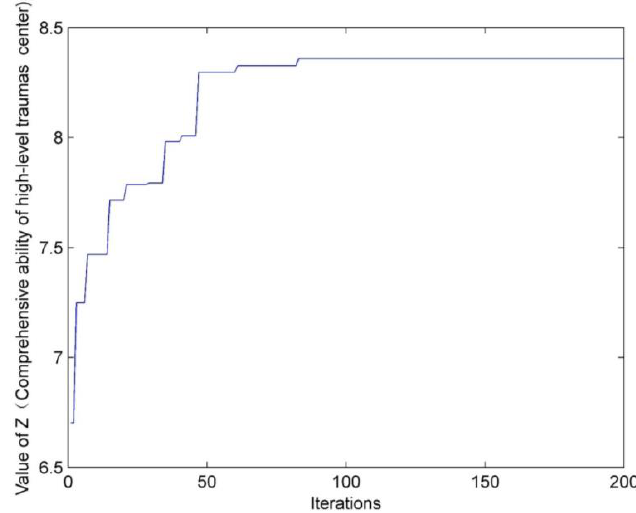
Figure 8. The convergence curve of z.